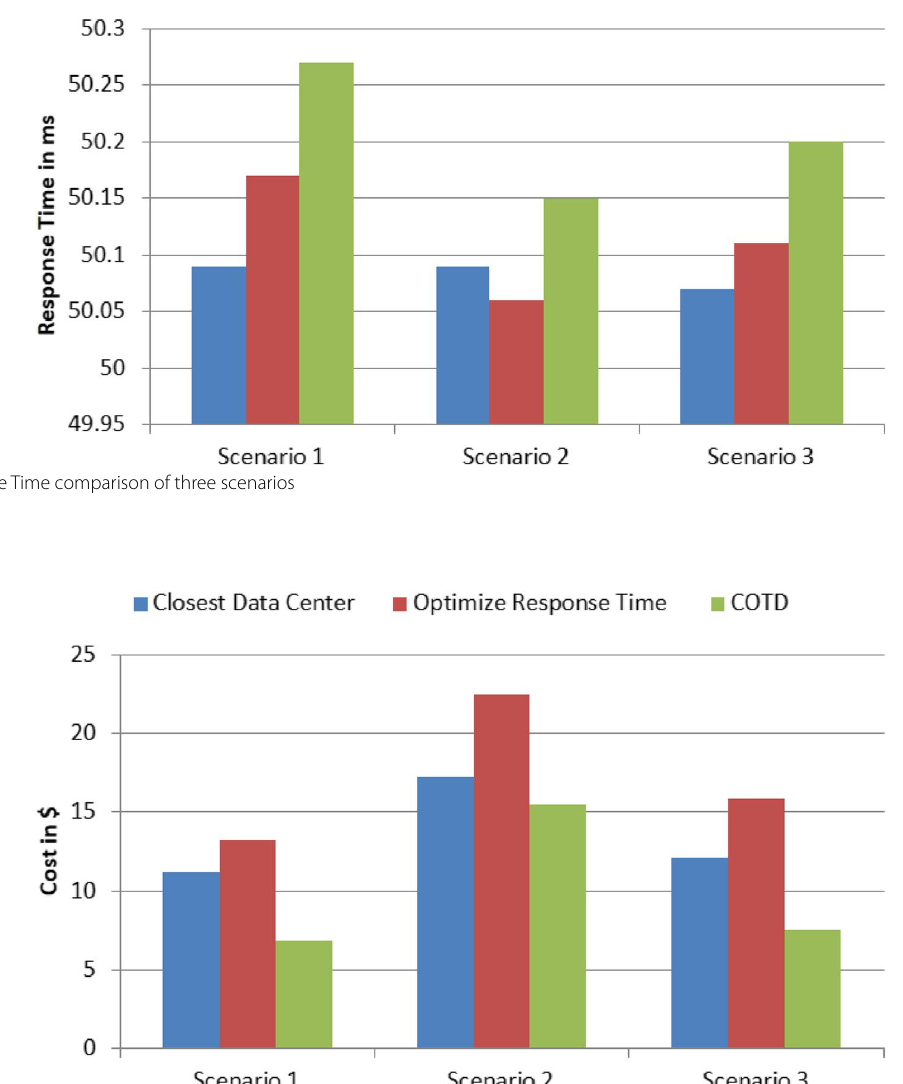
Fig. 9 Cost comparison of three